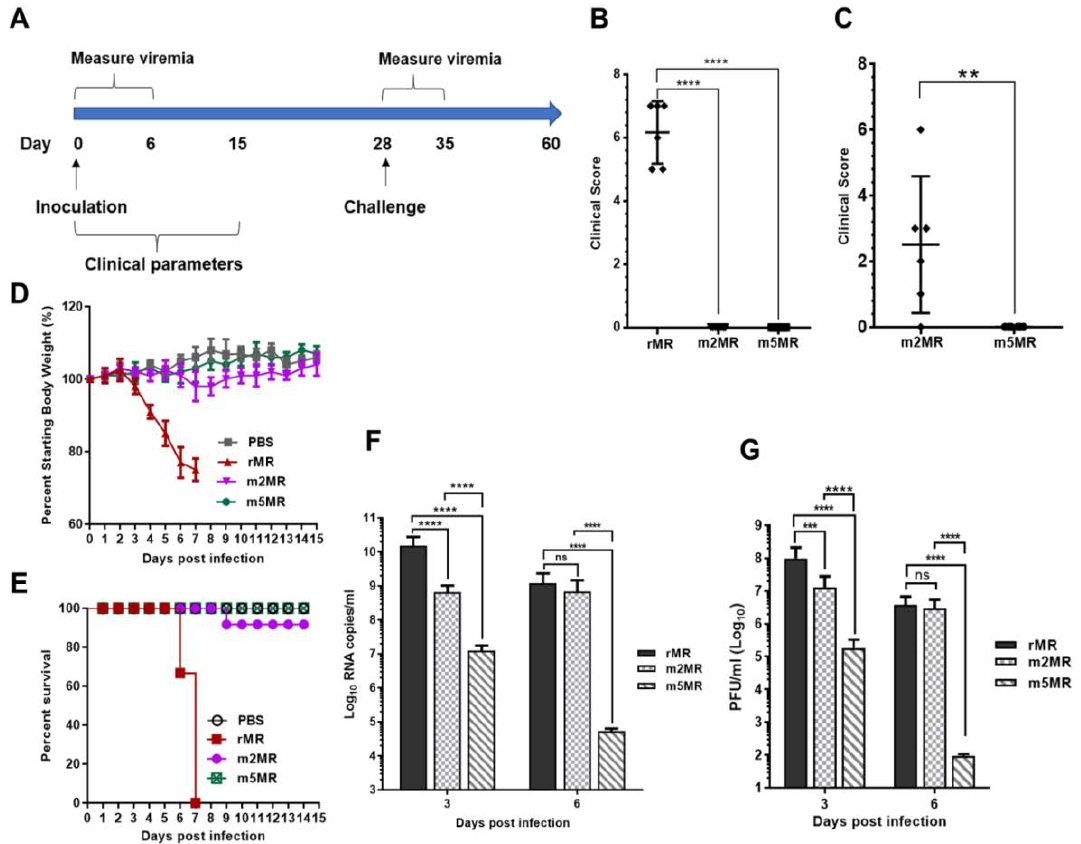
Figure 3. m5MR virus is attenuated in mice. ( A ) Scheme of virus inoculation and challenge study in three to four-week-old Ifnar1 − / − A129 mice. Mice were injected subcutaneously (s.c.) with 1000 PFU (plaque-forming unit) of rMR ( n = 6), m2MR ( n = 12), and m5MR ( n = 12) viruses on day 0. PBS was injected in the control group ( n = 6). Clinical scores at 6 dpi for rMR, m2MR, and m5MR virus-infected groups ( B ) and 10 dpi for m2MR and m5MR virus-infected groups ( C ). ( D ) Weight loss and ( E ) Percent (%) survival of mice in infected or PBS control groups. Viremia in serum at 3 dpi and 6 dpi as measured by genome copy numbers ( F ) and infectious virus titers ( G ). Data presented are combined data from two independent experiments. Unpaired Student’s t -test (two-tailed) (for panel ( B , C )) and Mann–Whitney test (for panel ( F , G )) were used to determine significance between groups. ****, p < 0.0001; ***, p < 0.001; **, p < 0.01; ns, non-significant.